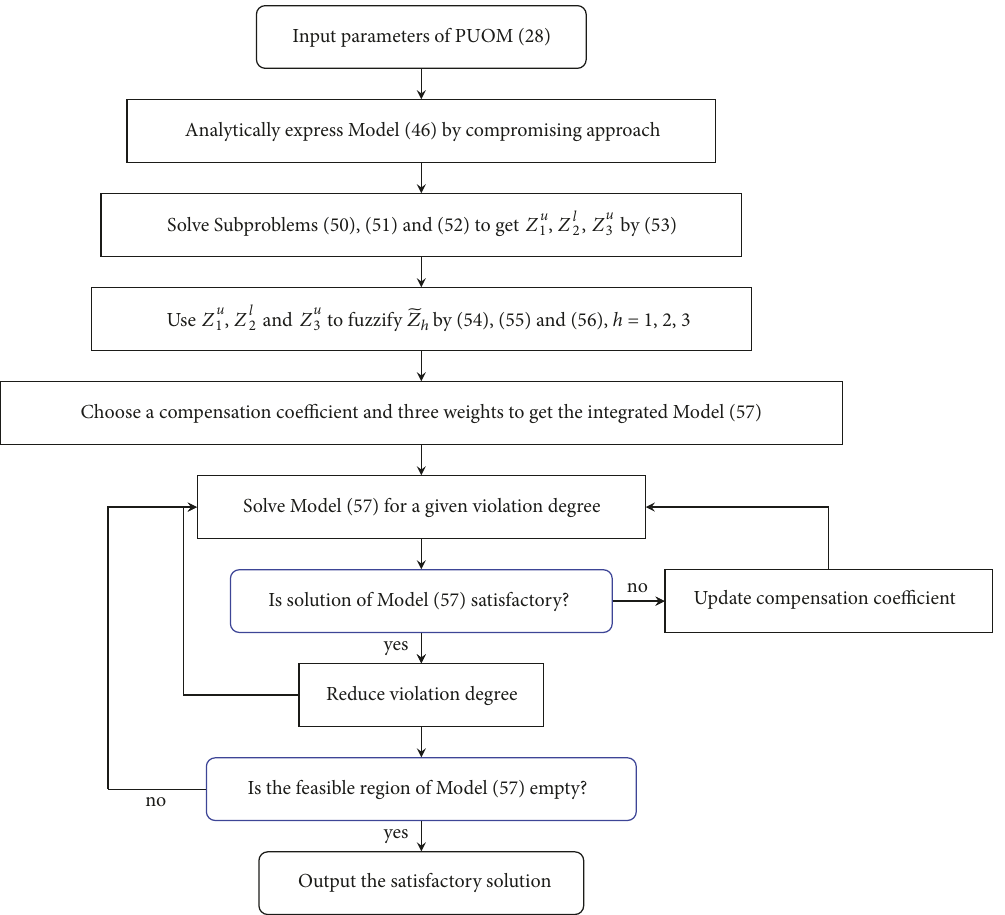
Figure 5: Logic chat of Algorithm